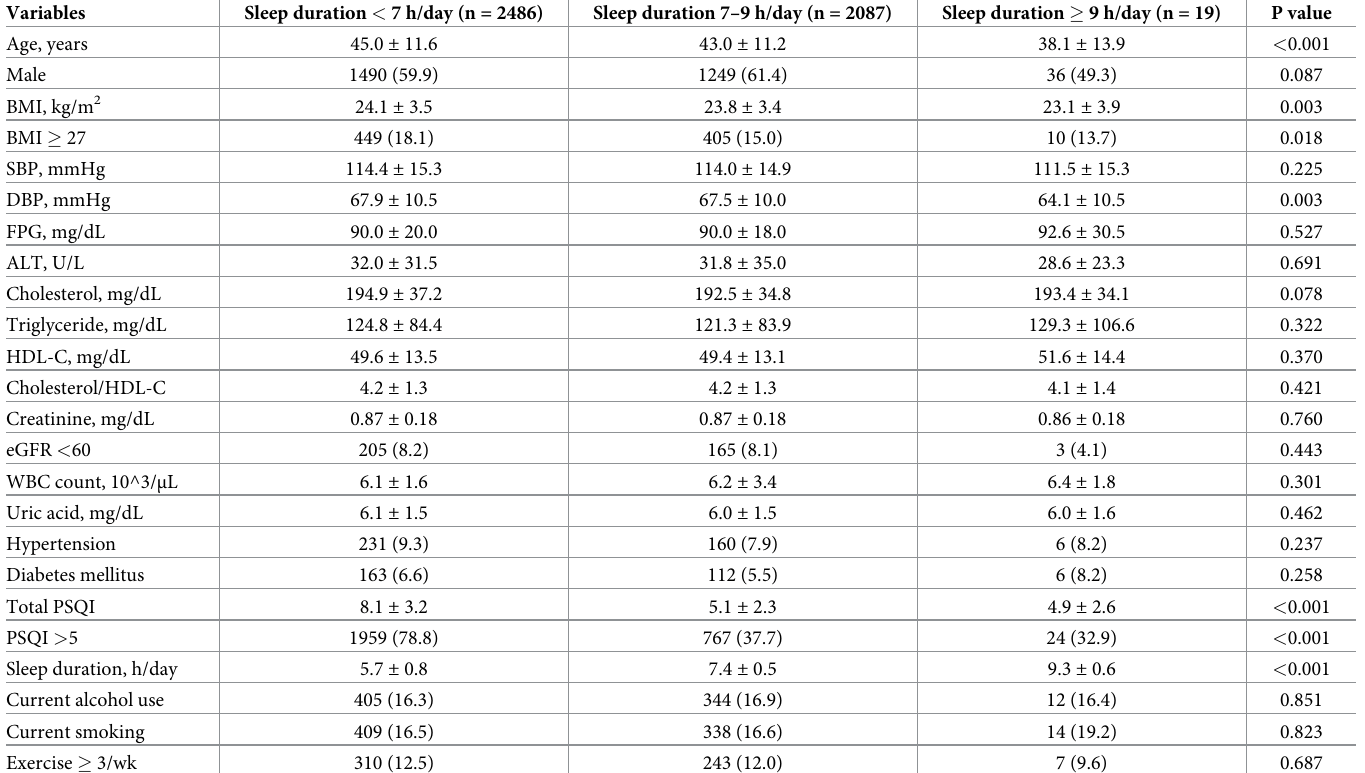
Table 2. Comparisons of participants’ clinical characteristics based on sleep